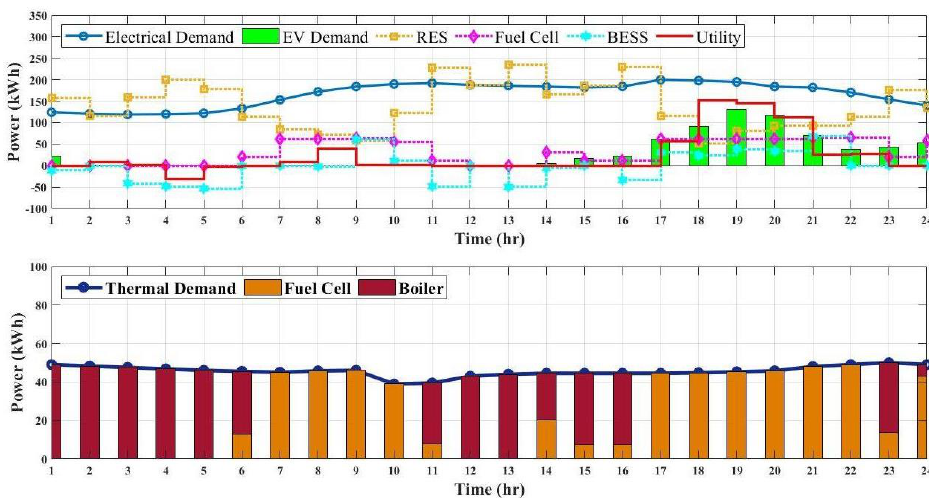
Figure 14. Introduction of the peak valley